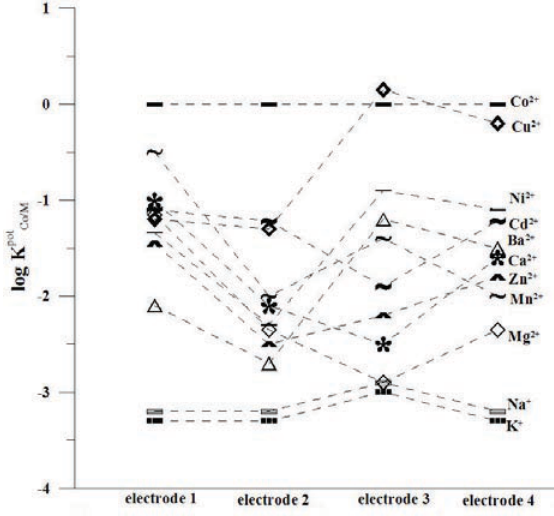
) of studied sensors Figure 5. Dynamic response of studied sensors. Co/M